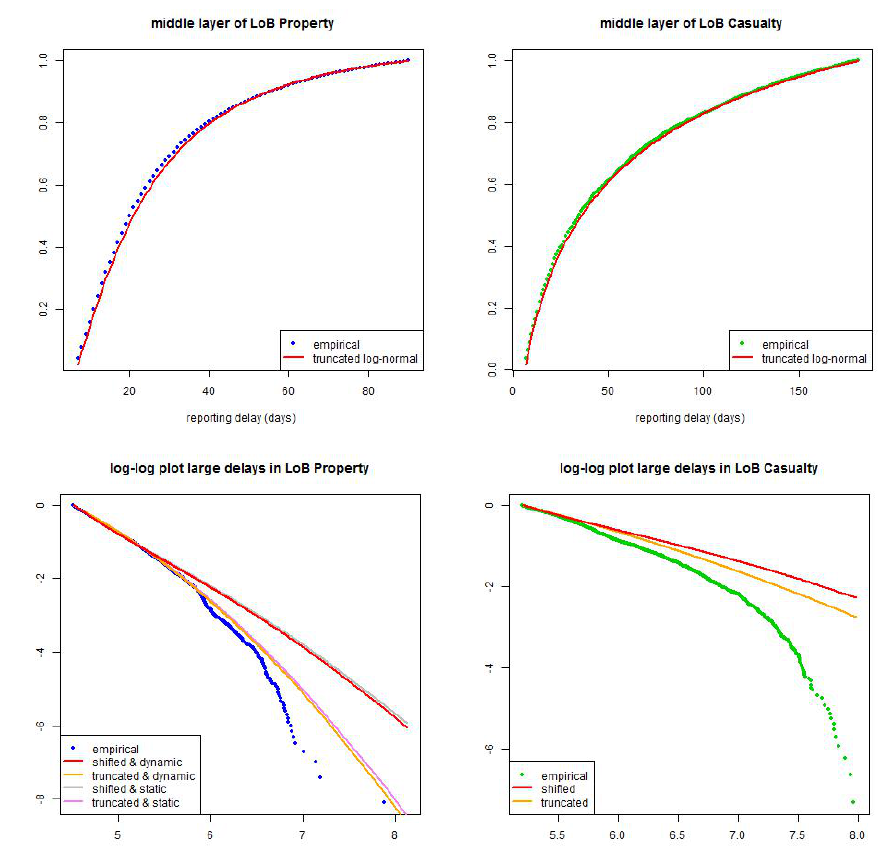
Figure 14. (top) calibration of truncated log-normal distribution in the middle layer [ u ( 1 ) , u ( 2 ) ) for (lhs) LoB Property with u ( 2 ) = 3 months and (rhs) LoB Casualty with u ( 2 ) = 6 months; (bottom) calibration of shifted and truncated log-normal distributions in the large layer [ u ( 2 ) , ∞ ) for (lhs) LoB Property with u ( 2 ) = 3 months (static and dynamic versions) and (rhs) LoB Casualty with u ( 2 ) = 6 months (only static